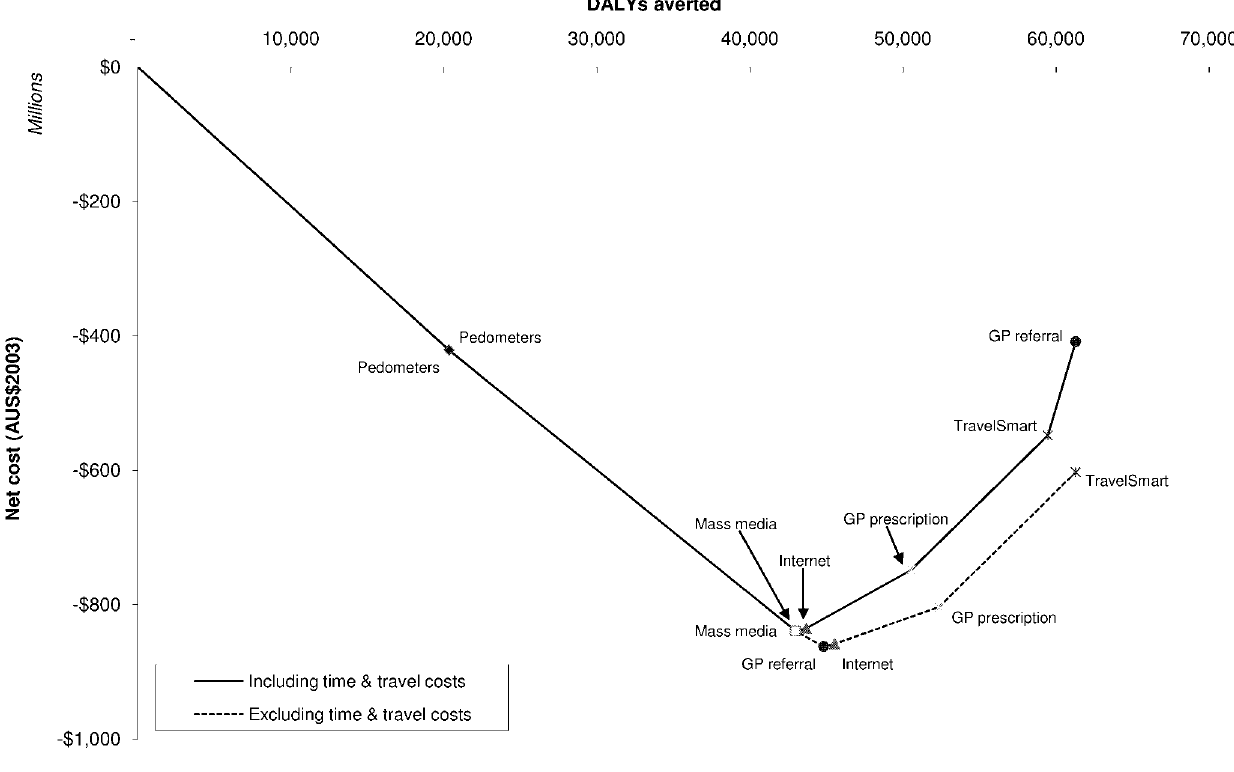
Figure 2. The physical activity intervention pathway.